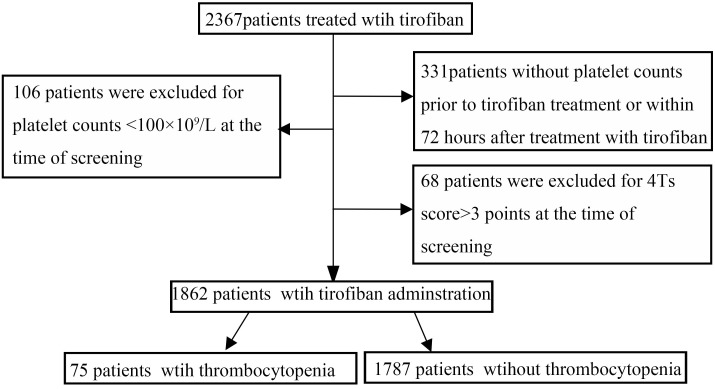
Flow chart depicting numbers of patients who were included in analysis after exclusion criteria. The total included encounters were divided into those with and without tirofiban-induced thrombocytopenia.